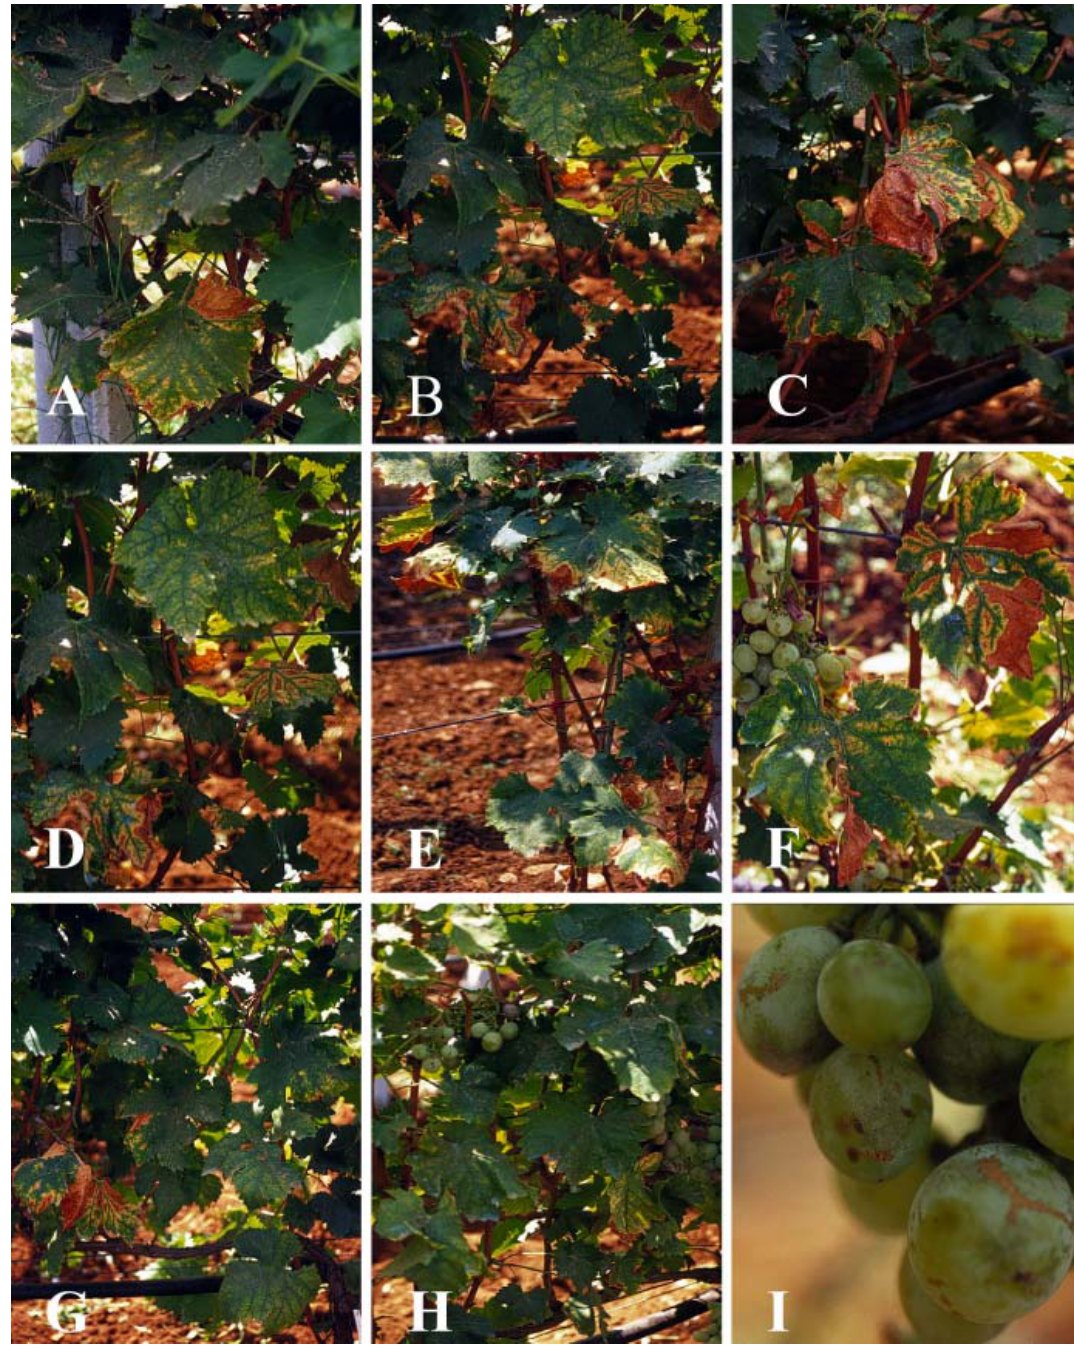
Fig. 3. Symptoms on leaves or berries of grapevines cv. Italia inoculated with: A. Phaeomoniella chlamydospora ( Pch ); B. Phaeoacremonium aleophilum ( Pal ); C. Fomitiporia punctata ( Fop ); D. Pch , Pal ; E. Pch ⇑ , Fop ⇓ . F. Fop ⇑ , Pal ⇓ ; G. Pal ⇑ , Fop ⇓ ; H. Fop ⇑ , [ Pal, Pch ] ⇓ ; I. Pch . With dual or triple inoculations, one fungus was inoculated either above ( ⇑ ) or below ( ⇓ ) the other(s); with the dual inoculation Pch+Pal, each fungus was inoculated at right angles on the same